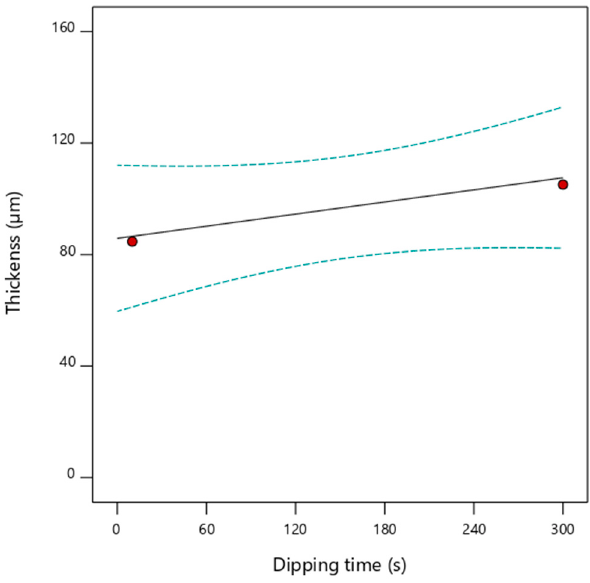
Figure 5. Dependence of coating thickness from dipping times (solid line) with the indication of the 95% confidence interval bands (dashed lines) and experimental design points (red circles), using sodium alginate at 5% w / w and CaCl 2 at 7% w / w as coating solutions. The corresponding linear regression equation describing the film thickness response ( R 2 = 0.95) as a function of dipping time alone is reported in Equation (11), for coded variables.